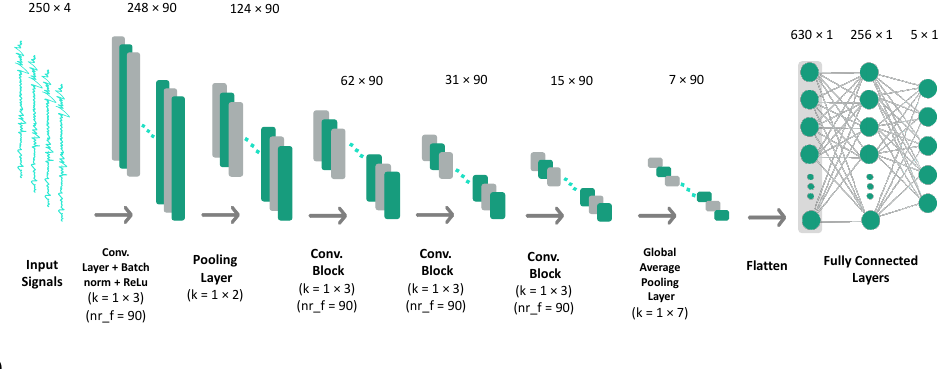
Figure 1. Convolutional neural network architectures. The values above the representation of each feature map indicate their shape (Signal length × Number of channels). Convolutional layers (1D): k = kernel size; nr_f = number of filters; stride = 1; padding = 0. Max pooling layers: k = kernel size; stride = 1; padding = 0. ( a ) CNN-simple Architecture. ( b ) CNN-base Architecture. ( c ) ResNet Architecture. The convolutional block is depicted in Figure 2.